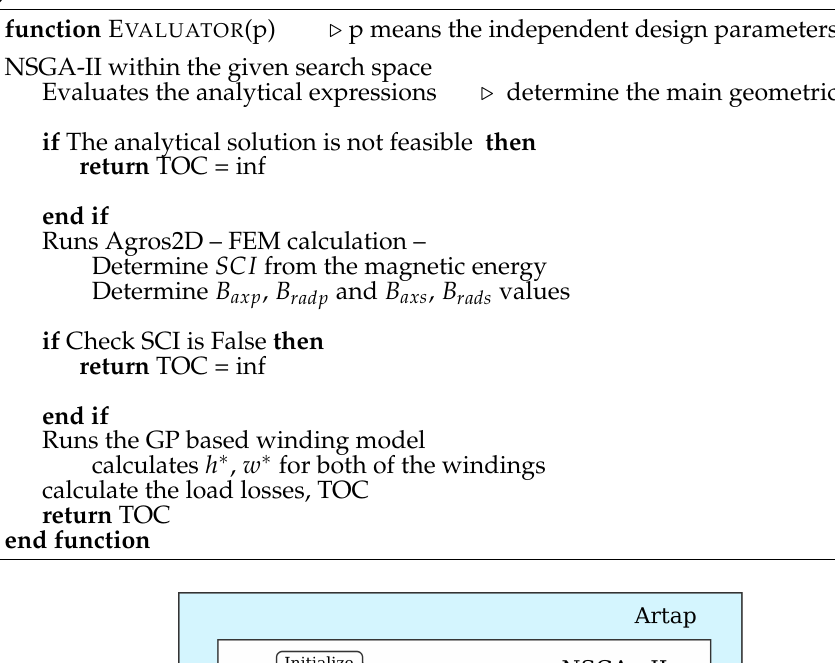
Algorithm 1 Transformer Model Evaluator function E VALUATOR (p)